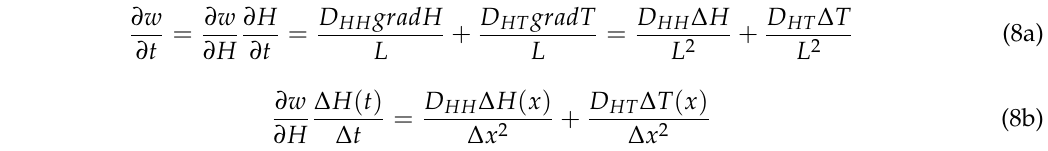
Figure 6. Relative humidity distribution profiles for all samples at the same time ( t = 10day).